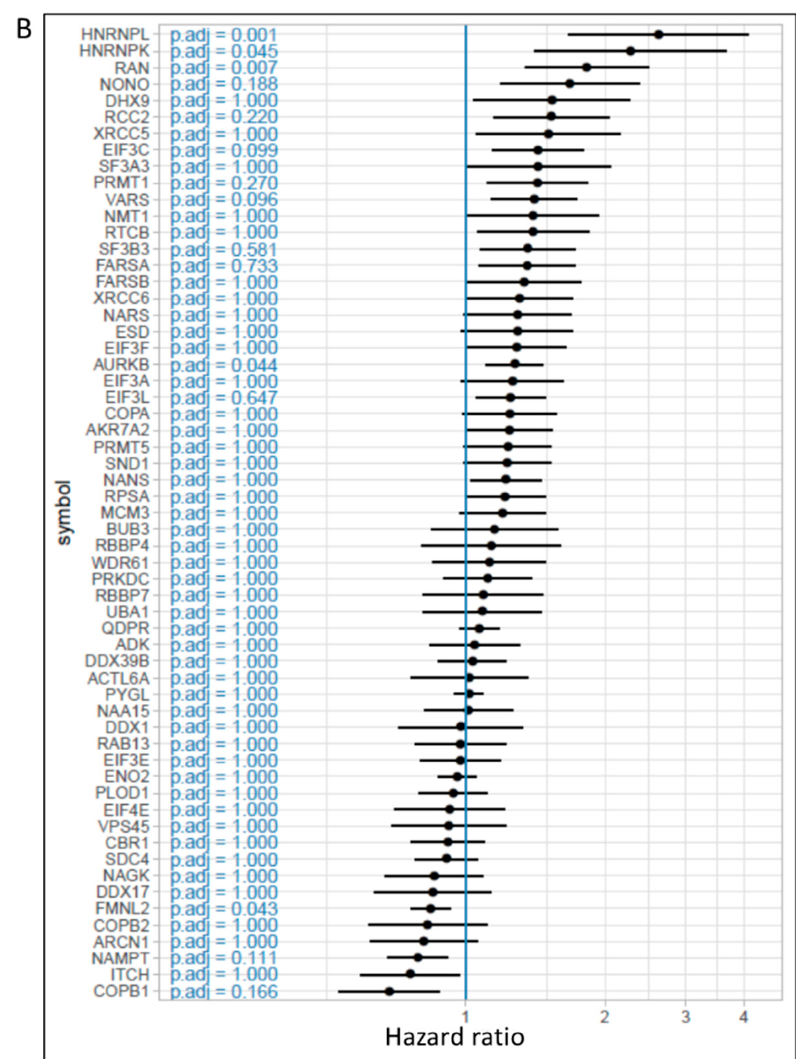
Figure 5. ( A ) Kaplan–Meyer curves of the survival of melanoma patients expressing high or low amounts of the selected genes (dataset: SKCM-TCGA Skin Cutaneous Melanoma July 2016). The table indicates the p -value, adjusted p -value and the function of the selected genes from Table S1. Low and high expression groups are marked in green and red, respectively. The total patient number for each group is indicated in the top right corner and the number of censoring samples are shown with + . The concordance index (CI) per curve is presented. On the y axis, the probability is represented; on the x axis, the time in days (black) is shown and the number of samples for low (green) and high (red) expression groups who are not presenting the event at the matching time. ( B ) Forest plot representing hazard ratio and confidence intervals from Cox models for the selected genes (dataset: SKCM-TCGA Skin Cutaneous Melanoma July 2016). Models accounting for stage group e ff ect were run separately on each gene and p -values were adjusted by false discovery rate (also see Section